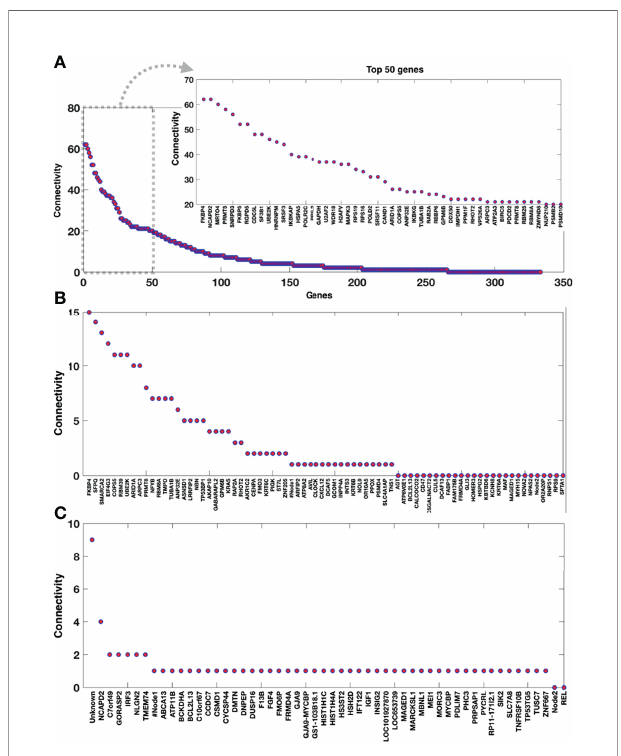
FIGURE 3 | Connectivity of the genes within the DEGs networks. Genes connectivity in the DEG networks (A) DHF versus ND, (B) DF versus ND, and (C) DF versus DHF.